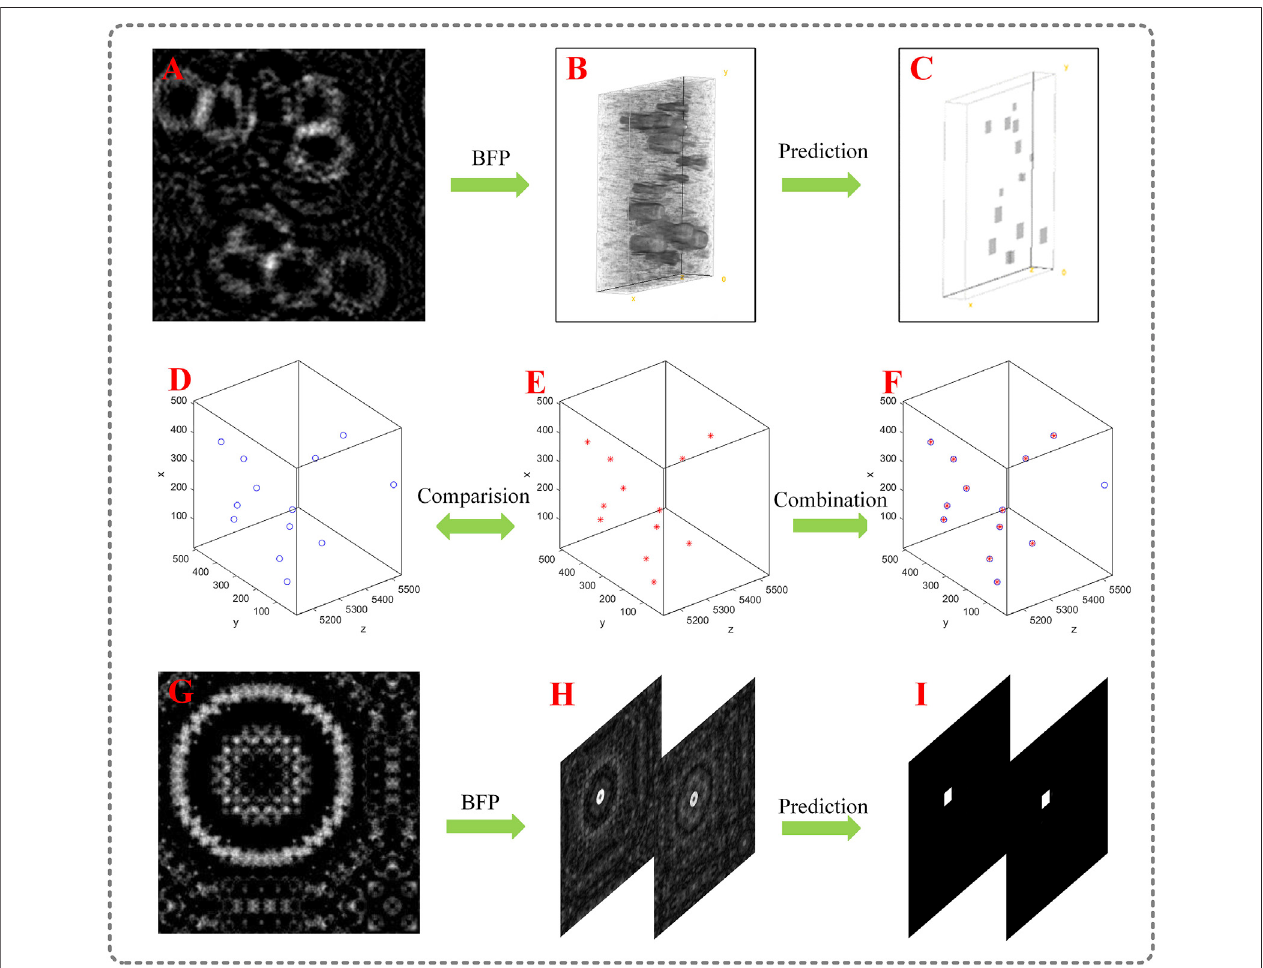
FIGURE 2 | Simulation result; (A) a pre-processed hologram with multiple particles; (B) the reconstruction of (A) using BFP; (C) prediction of (B) by the U-net model; (D) ground truth position of the particle fi eld, the blue circles represent ground truth particles; (E) 3D predicted position of the particle fi eld by extracting the information in (C) ; (F) Combination of ground truth and prediction; (G) a pre-processed hologram with overlapped particles; (H) raw-reconstructed images of (G) ; (I) prediction corresponding to (H)